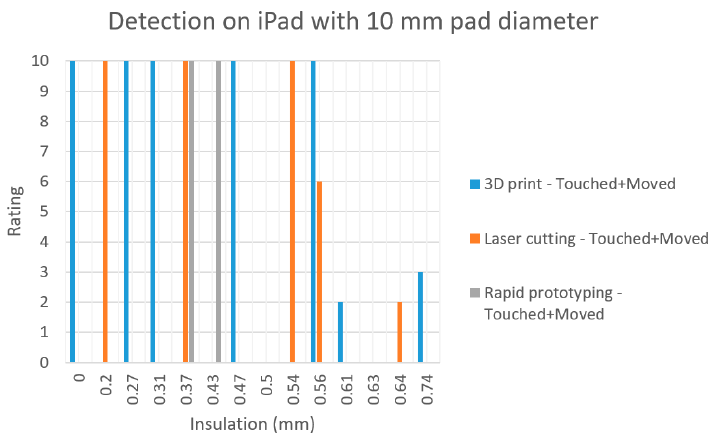
Figure 15. Detection performance (“Rating”) of different marker types with varying insulation layer using the large markers on the iPad. Contrary to the previous figures, these results show the interaction “Touched and Moved”.